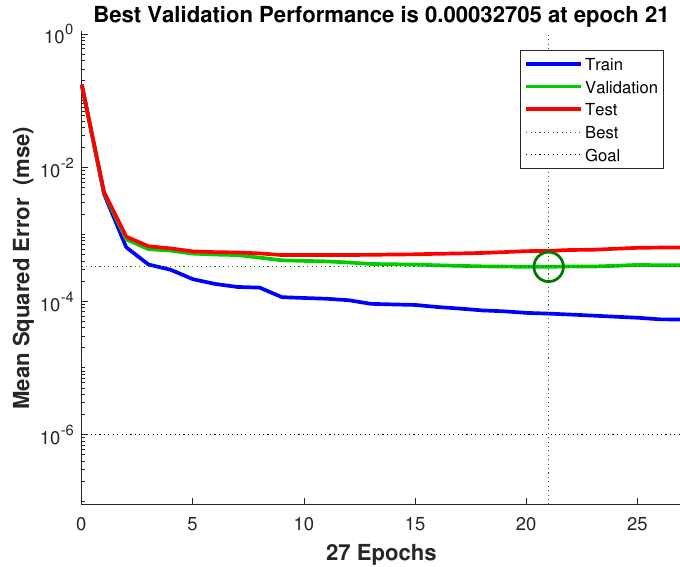
Figure 3. Training process of the proposed neural